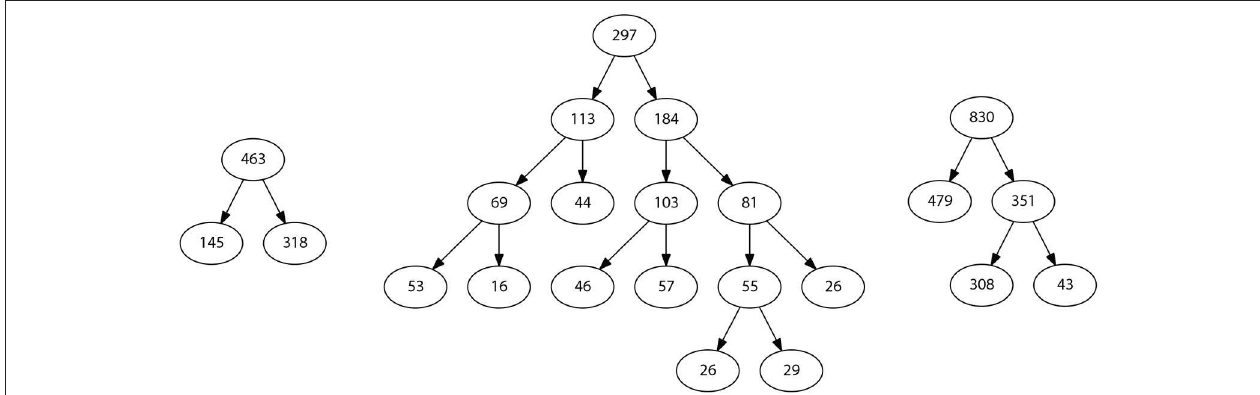
FIGURE 2 | Representative schemes of the partitions and the flows of divisions generated for the example datasets associated with case study I: Thoracic Surgery dataset (left) , Heart Disease Cleveland dataset (center) , and Mamographic Mass dataset (right) . The number of final partitions, their cardinality and the performance measures achieved by the models trained in each case are also